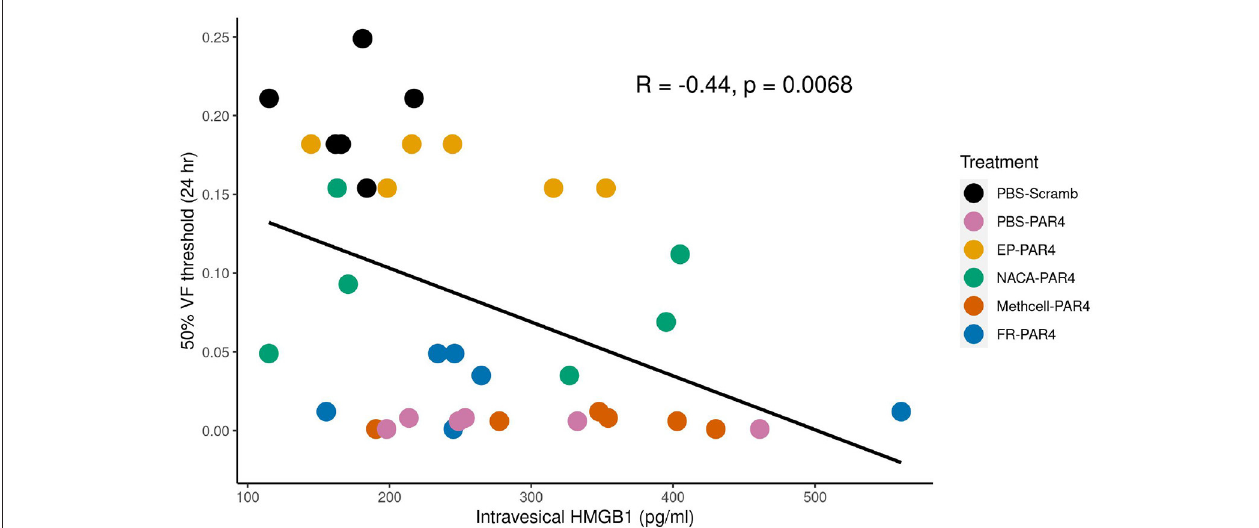
FIGURE 3 | von Frey (VF) threshold is negatively correlated with intravesical high mobility group box 1 (HMGB1) levels in the intravesical fluid. Scatter plot shows a significant negative correlation between intravesical HMGB1 level (x-axis) and 50% VF threshold score (y-axis) indicating that higher HMGB1 concentrations correlate with greater BHA. Treatment groups are color coded as indicated in the